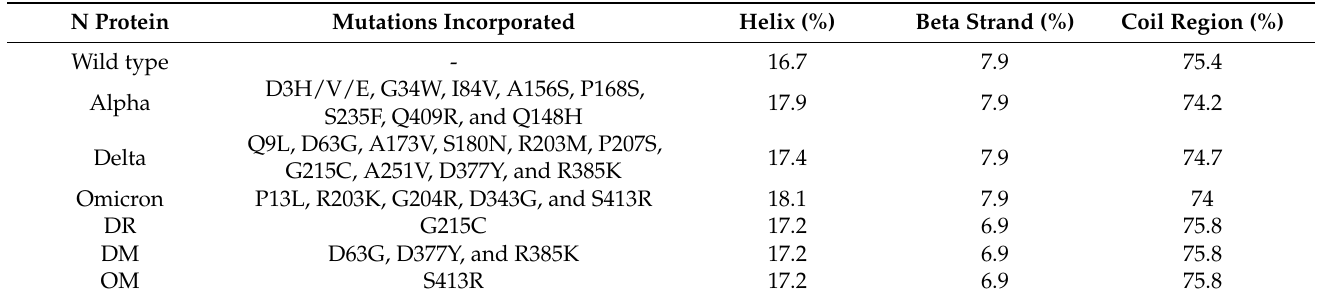
Table 1. Secondary structure changes in overall N